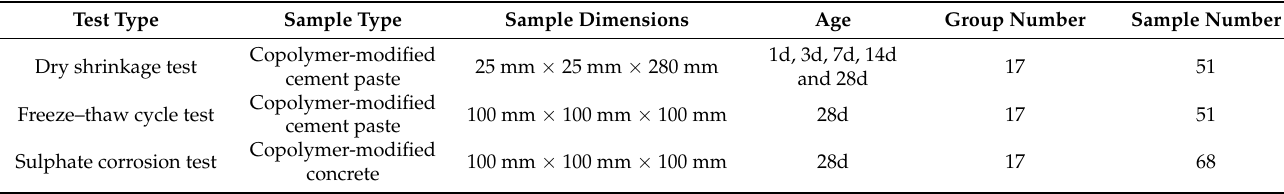
Figure 1. Stirring of copolymer-modified pervious concrete mixture. Table 4. Sample dimensions for various